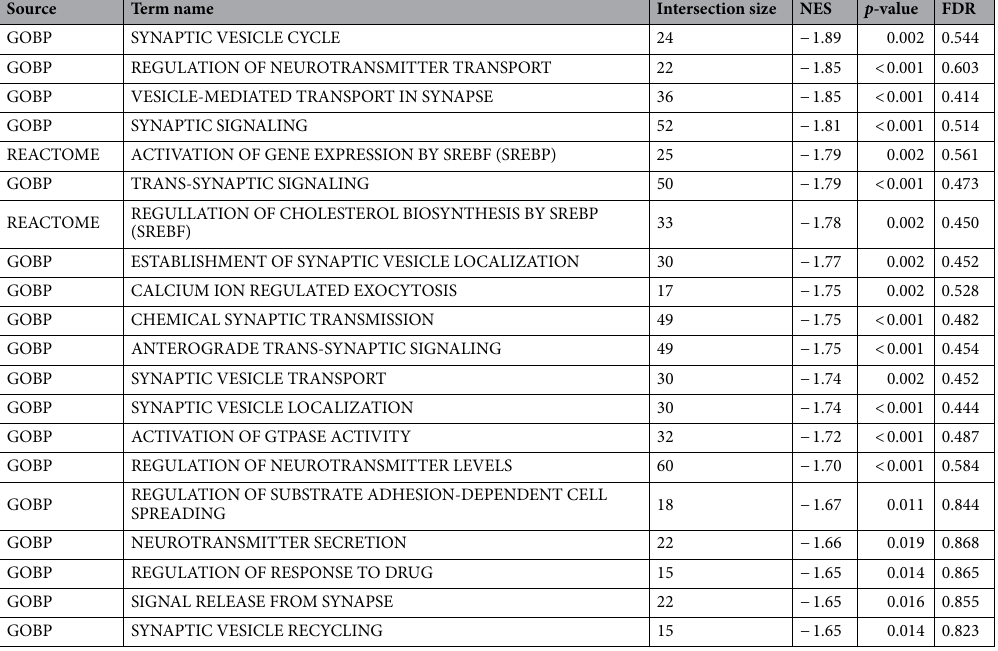
Table 3. Functional terms downregulated by the balanced agonist quinpirole as determined by gene set enrichment analysis. The 20 functional terms with the lowest NES are shown.